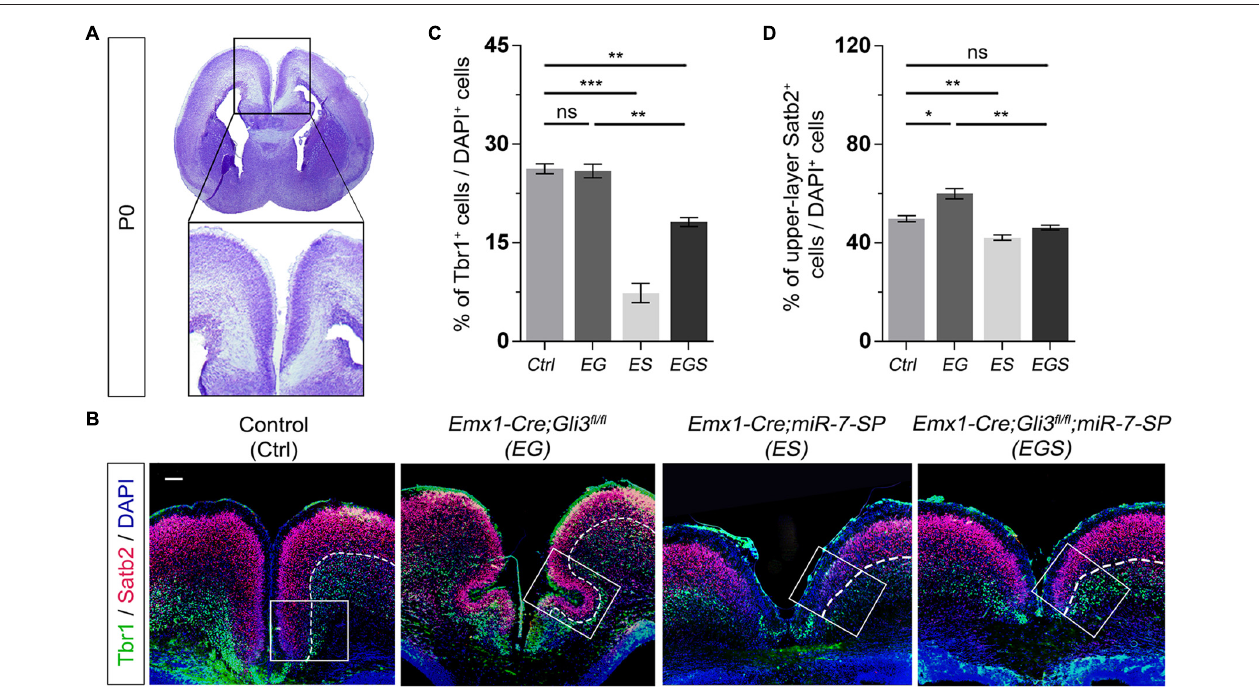
FIGURE 4 | Gli3 and miR-7 regulate population of newborn neurons in the cortical midline through an opposite effect. (A) The position that was captured and presented in the P0 cortical midline region. (B,C) Absence of Gli3 showed no alteration of Tbr1 + /DAPI + neurons in the deep layer. But losing function of both miR-7 and Gli3 significantly reduced the population of Tbr1 + /DAPI + cells. Knockdown of miR-7 significantly reduced the proportion of Tbr1 + /DAPI + neurons in the deep layer. (B,D) The upper layer neurons were separated according to the zones of Satb2 + intensive cell layer and Tbr1 + marked layer using the white dotted line. Cortical deficiency of Gli3 increased the proportion of upper layer Satb2 + /DAPI + cells, which was rescued by silencing miR-7. Knockdown of miR-7 significantly reduced the proportion of Satb2 + /DAPI + neurons in the upper-layer. The markers Tbr1, Satb2 and DAPI stained for newborn neurons in deeper layer, newborn neurons in upper layer and all cells, respectively. Values represent mean ± SEM. n > 9. ∗ P < 0.05; ∗∗ P < 0.01; ∗∗∗ P < 0.001; ns, not significant. One-way ANOVA with post hoc test was used. Scale bar = 100 µ